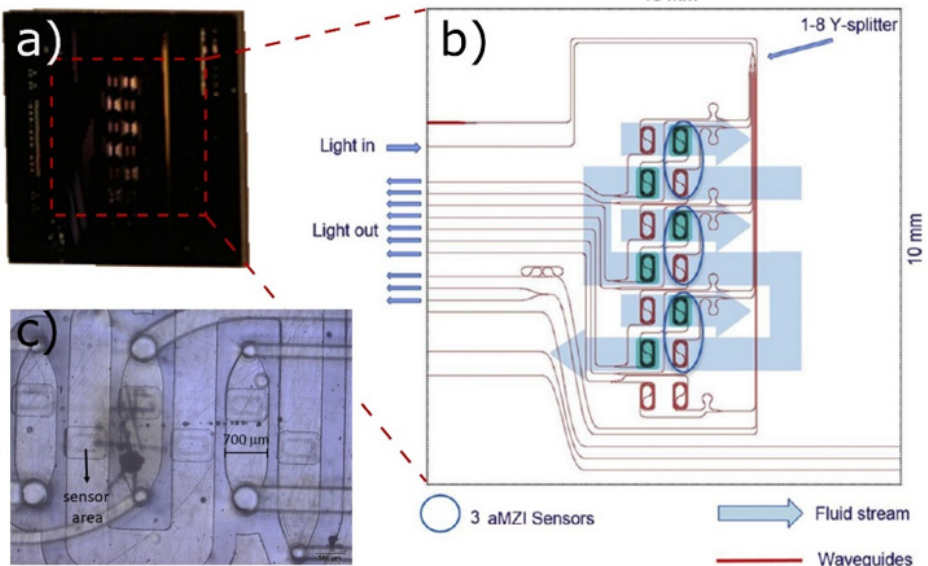
Figure 5. Multiplexed asymmetric Mach–Zehnder interferometer (aMZI) biosensor. ( a ) Photo of a chip; ( b ) layout scheme of the sensor chip: three sensors with an individual flow path and three with common flow path. ( c ) Close up image of three sensing elements, isolated by the soft acrylate sealing layer pressed above the aMZI. Adapted from [300]. Copyright (2020) with permission from Elsevier.